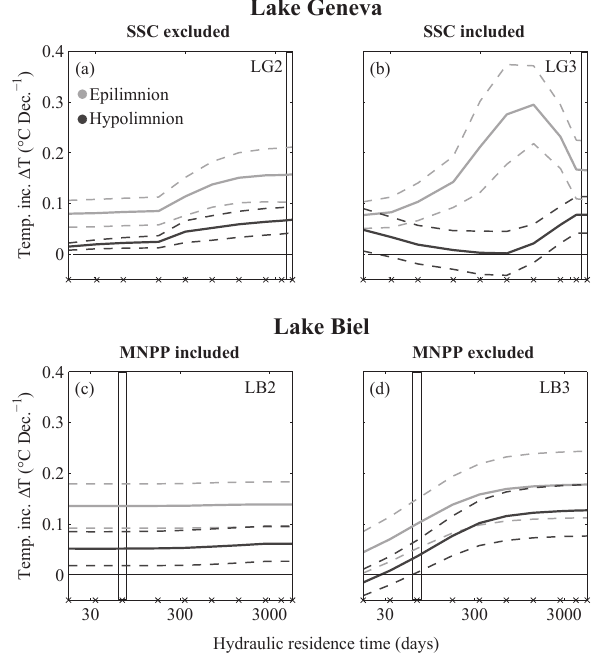
Figure 9. Variation in lake hydraulic residence times (changed lake volume) in response to modeled temperature increase ( (cid:49)T ) in the epilimnion (grey) and hypolimnion (black) displayed as decadal mean (solid line) and standard deviation (dotted line) for LG (a, b) and LB (c, d) . River-borne SSC included (b) and ex- cluded ( a , c and d ), MNPP heat input included in (c) and ex- cluded (d) from near-future and far-future time periods but retained for the reference period. Black x’s mark modeled lake residence times, while full-height black rectangles mark the lakes’ present- day residence